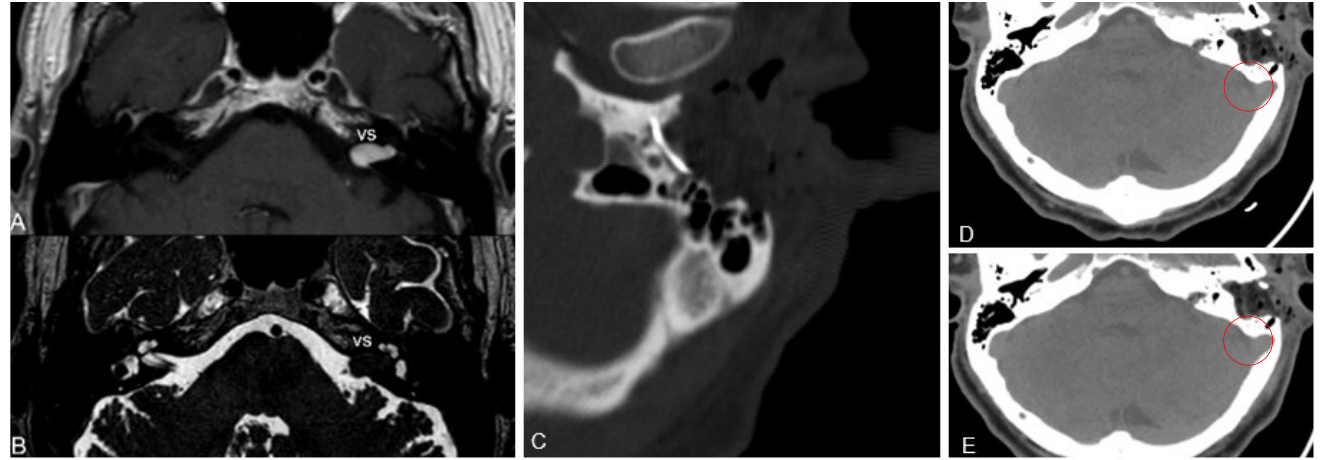
Figure 2. Preoperative and postoperative imaging of patient no. 1. ( A ) Axial gadolinium enhance- ment T1—weighted MRI. ( B ) T2—weighted drive HR MRI. ( C ) Postoperative CT—scan that shows